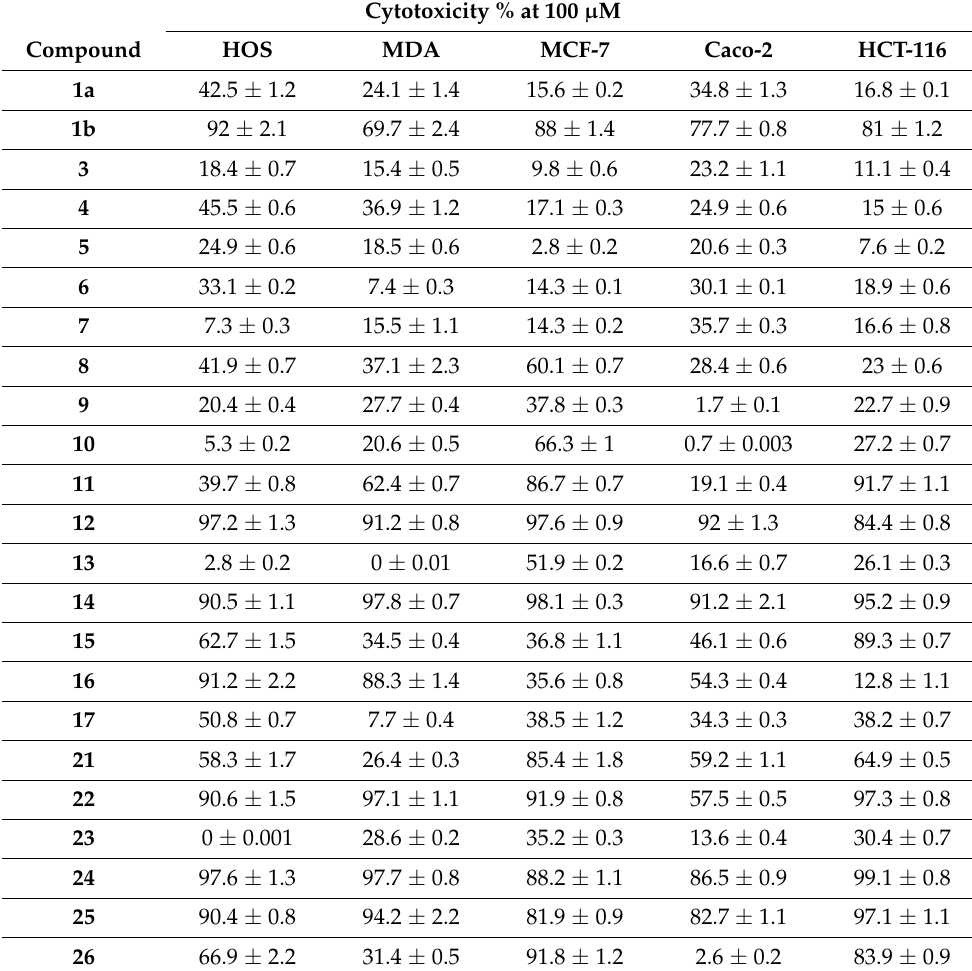
Table 1. In vitro screening of the antiproliferative activities of the compounds against HOS, MDA- MB-231, MCF-7, Caco-2, and HCT-116 cancer cell lines. Preliminary concentration for screening was 100 µ M for 48 h; each result is a mean of three replicate samples and values are represented as % inhibition, ± represents standard deviation. Cytotoxicity % at 100 µ M